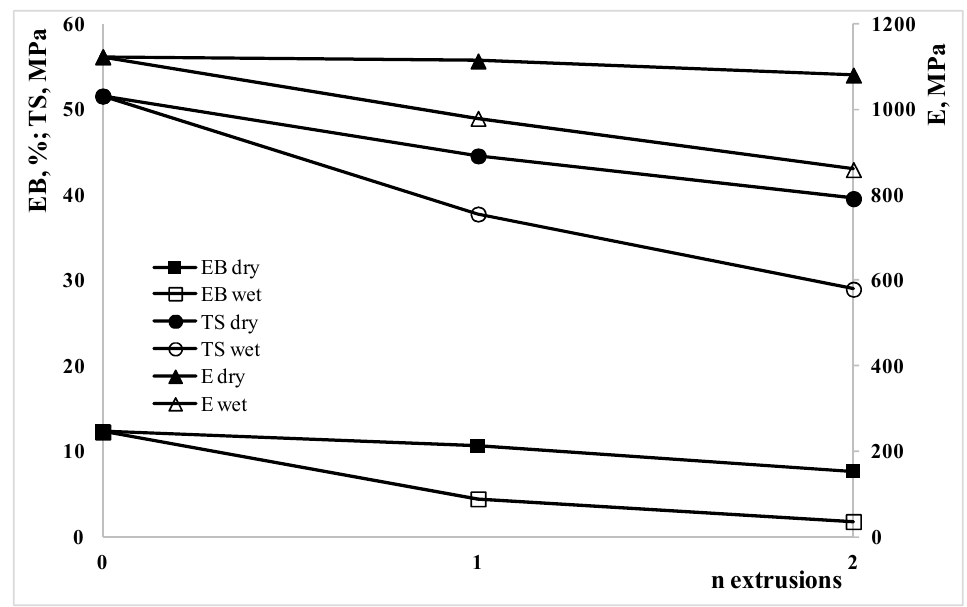
Figure 9. Elastic modulus, TS, tensile strength, and, EB, elongation at break as a function of the extrusion steps, for both dry and wet samples.